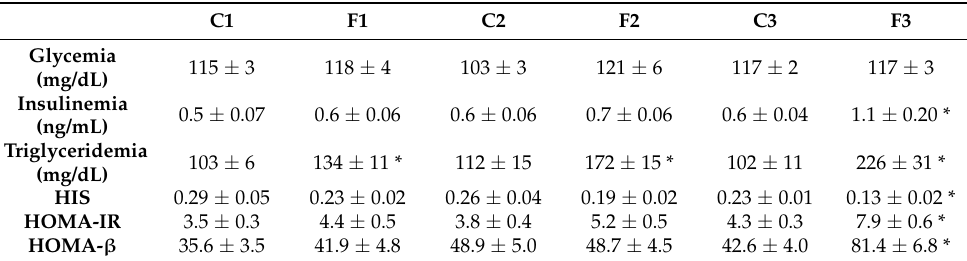
Table 3. Seric parameters and derived indexes at each time